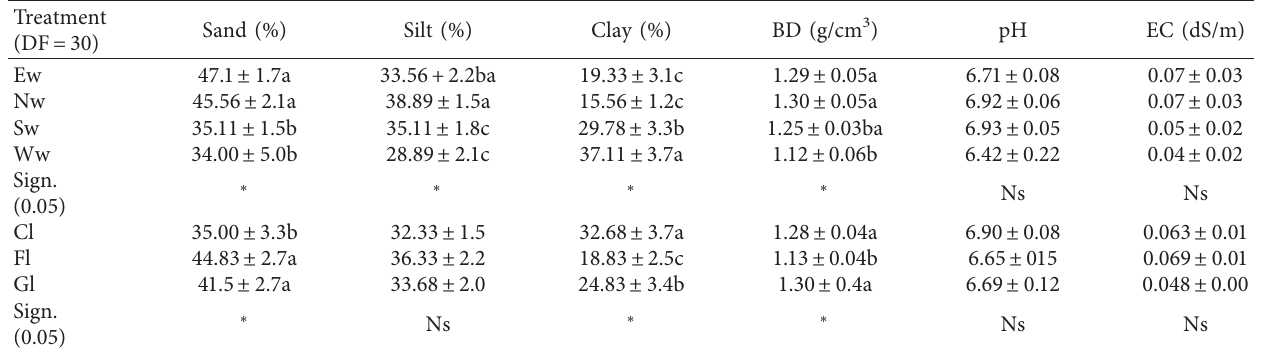
Table 2: Main effect of slope aspect and land use types on selected soil properties.